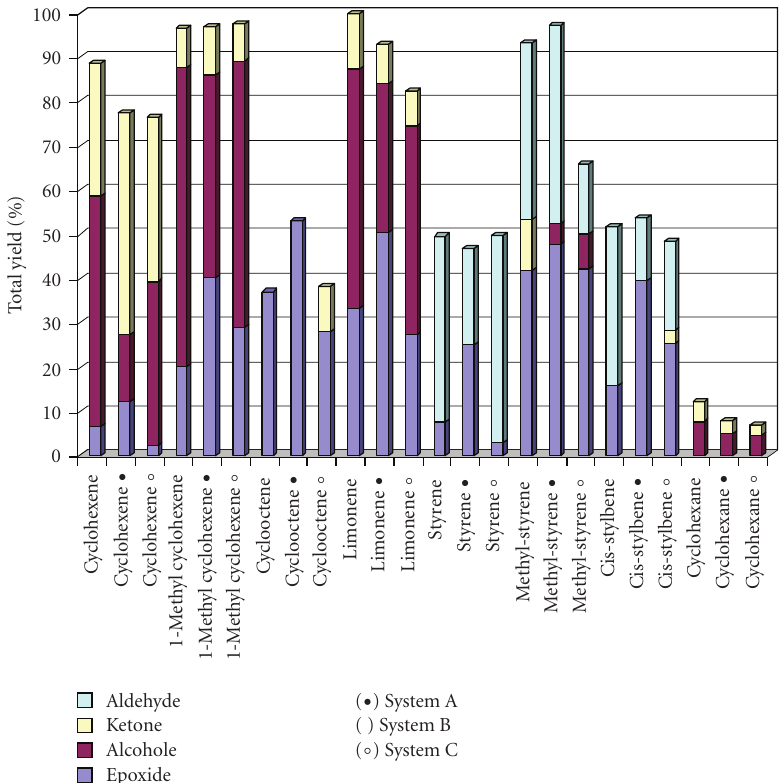
Figure 4: Distribution of oxidation products catalyzed by LFe III Cl, (a) in tert-amylalcohol with H 2 O 2 , (b) in CH 3 CN with H 2 O 2 , and (c) in CH 3 CN with tert-BuOOH. See Table 2 for further